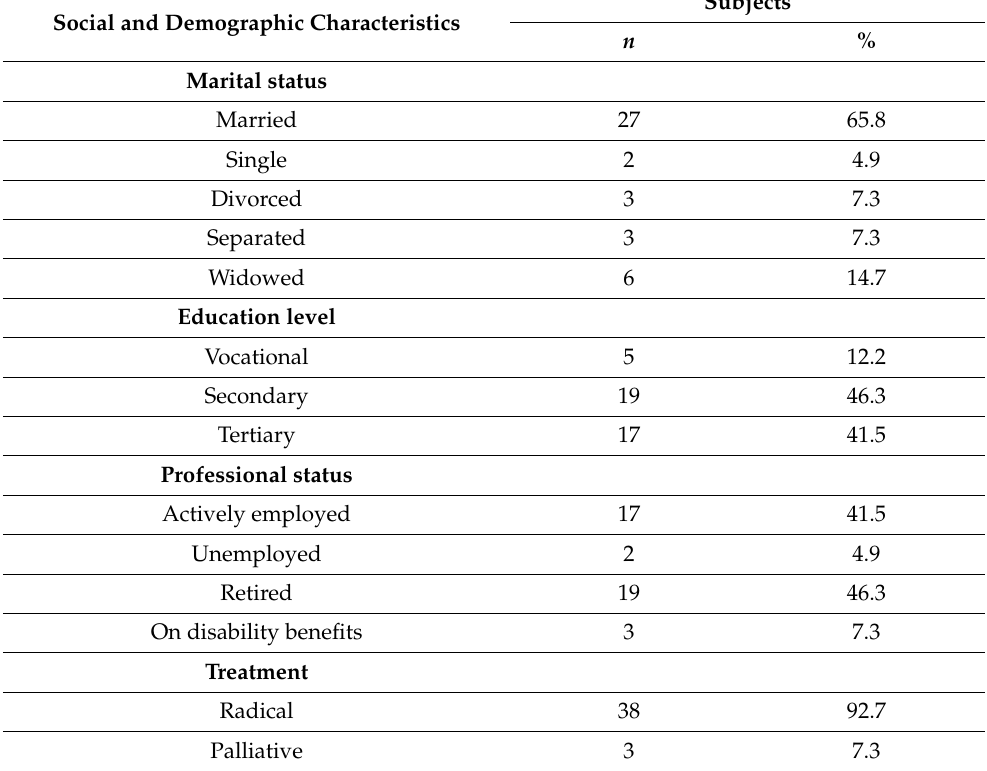
Table 1. Social and demographic characteristics of the study